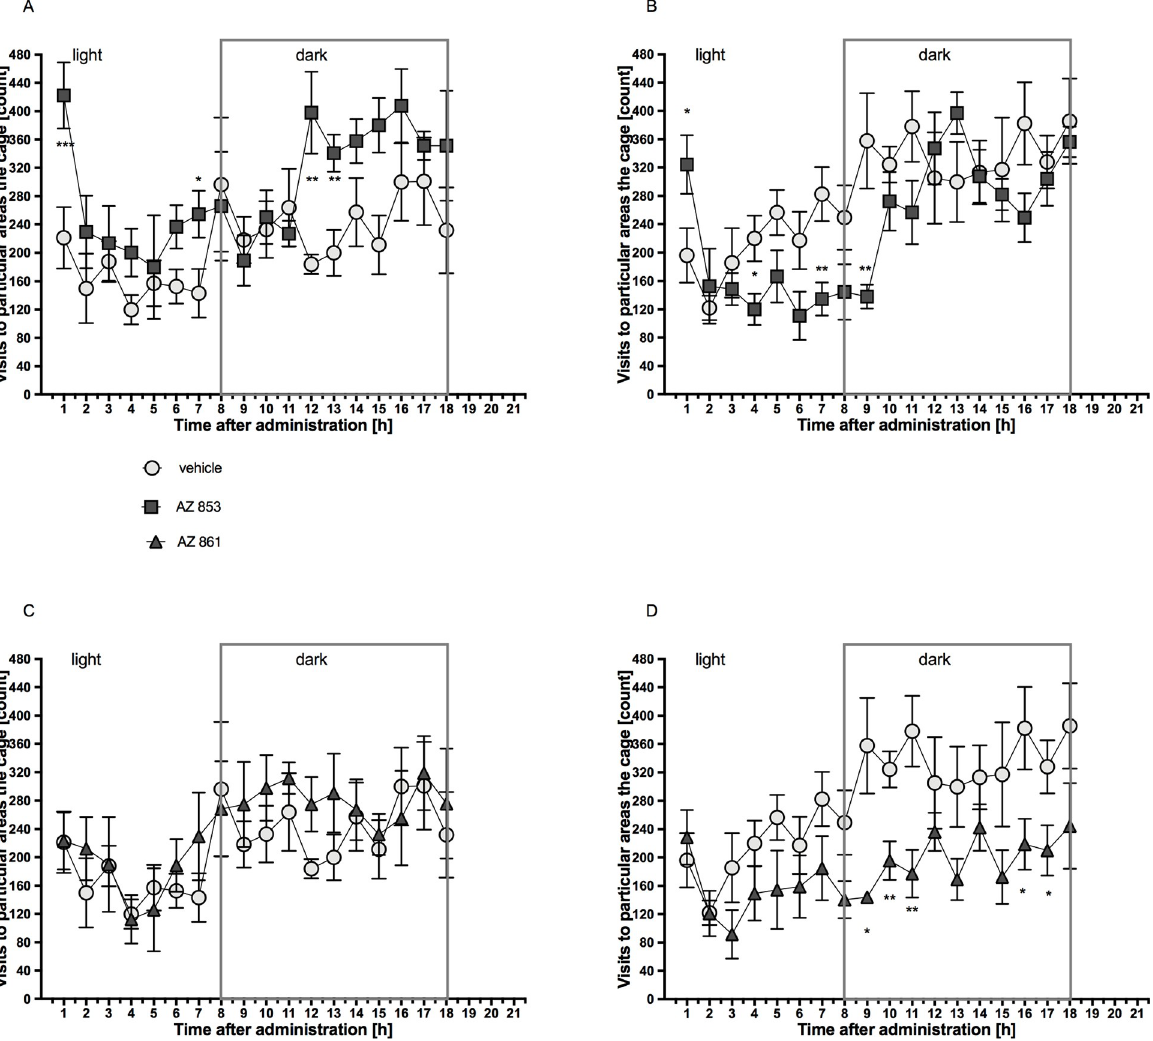
Fig 13. Effects of AZ-853 and AZ-861 administration on the spontaneous activity of mice during light and dark phases. A–after the 1st administration of AZ-853, B–after the 15th administration of AZ-853, C–after the 1st administration of AZ-861, D–after the 15th administration of AZ-861. Each plot represents mean ± SEM for n = 7–8 per group. Statistical analysis was performed using multi-t test, � p < 0.05, �� p < 0.01 vs. control.